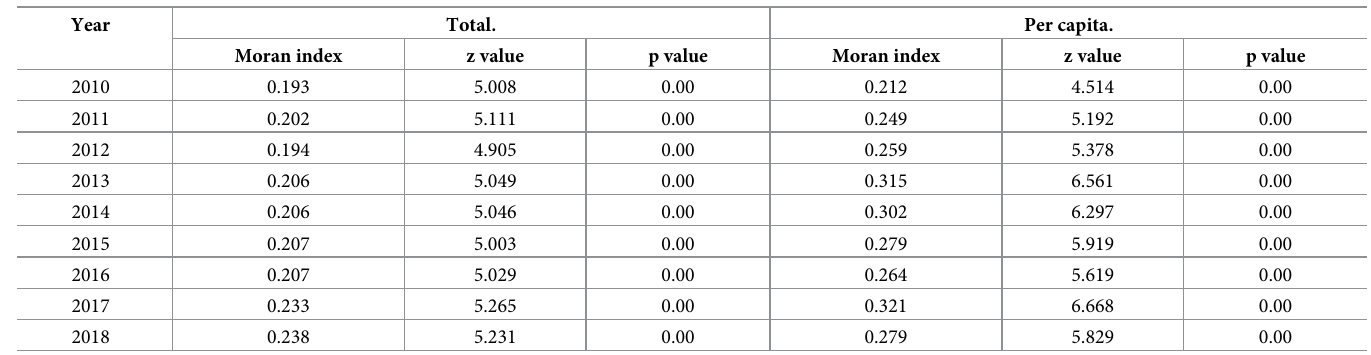
Table 2. Spatial autocorrelation test of carbon emissions from civil buildings. Year Total.